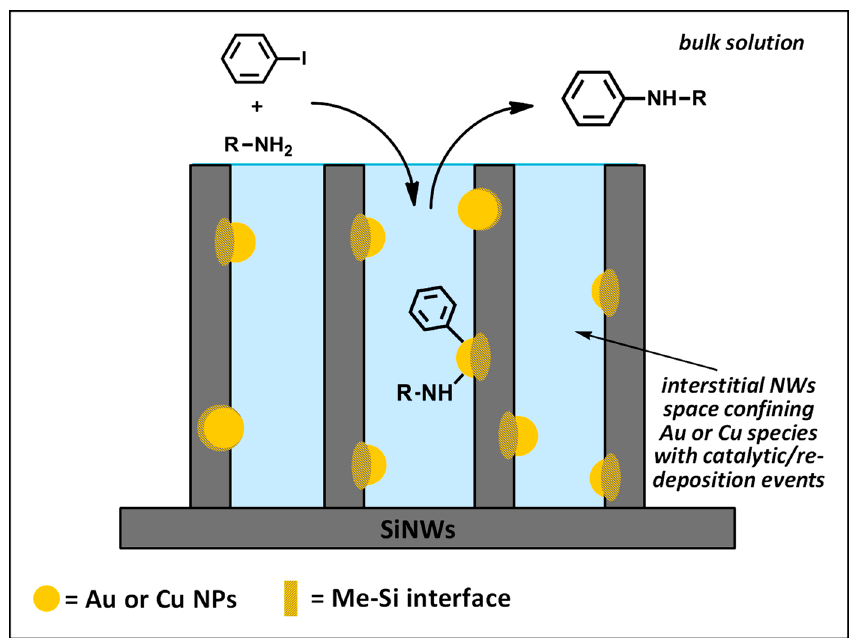
Figure 9. Schematic of C aryl –N coupling occurring into the interstitial space of SiNWs.